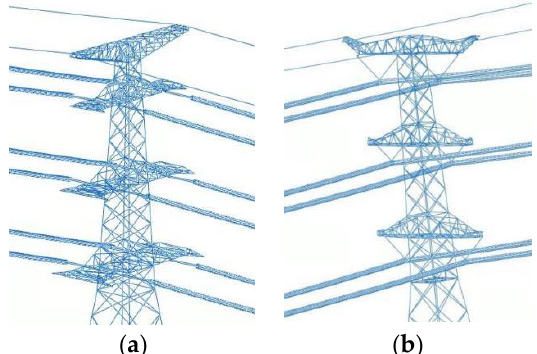
Figure 7. Schematic diagram of the conductor suspension methods: ( a ) Suspension method of tension tower; ( b ) Suspension method of tangent tower.